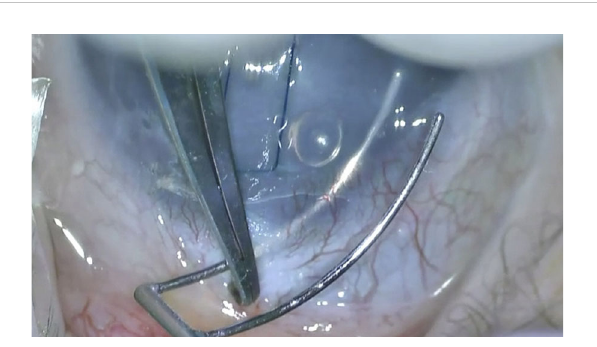
FIGURE 2 Aqueous re fl ux from the cut ends of the Schlemm